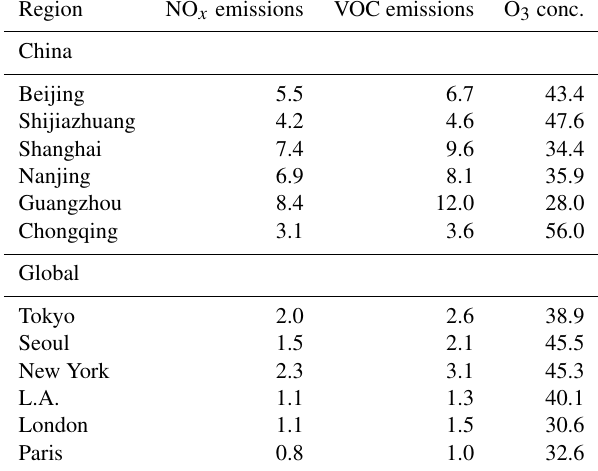
Table 5. Anthropogenic NO x and VOC emissions ( × e − 10 kgm − 2 s − 1 ) and summertime mean surface O 3 con- centrations (ppb) in regions across the industrial regions of China and the globe. MEIC emissions of 2013 adjusted for 2016 are used for Chinese industrial regions. HTAP emissions of 2010 are used for other regions of the